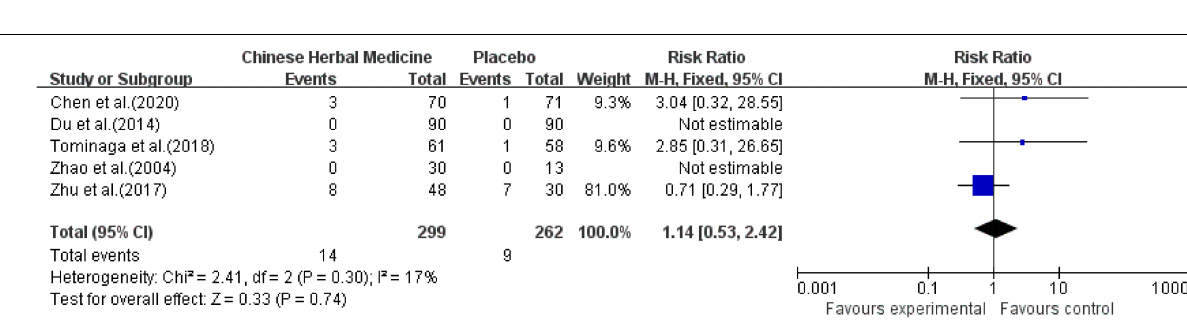
FIGURE 10 | Meta-analysis of gastric emptying rate of CHM vs. western medicine group.